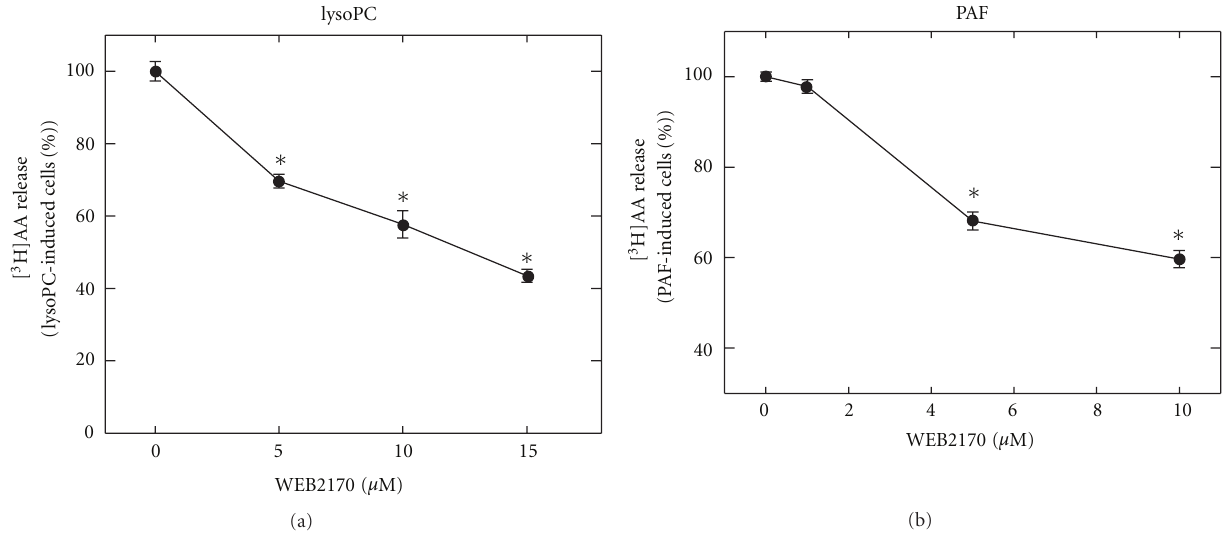
Figure 6: LysoPC-mediated [ 3 H]AA release is inhibited by the PAF-receptor antagonistWEB2170. Prelabeled THP-1 cells were preincubated with WEB2170, stimulated with (a) lysoPC (40 μ M, 10min.) or (b) PAF (35 μ M, 5min) and [ 3 H]AA release in the medium was measured by liquid scintillation counting . Data are expressed as means ± SD of triplicate determinations within separate experiments. Asterisks indicate that values are statistically di ff erent from PAF- or lysoPC-treated cells ( ∗